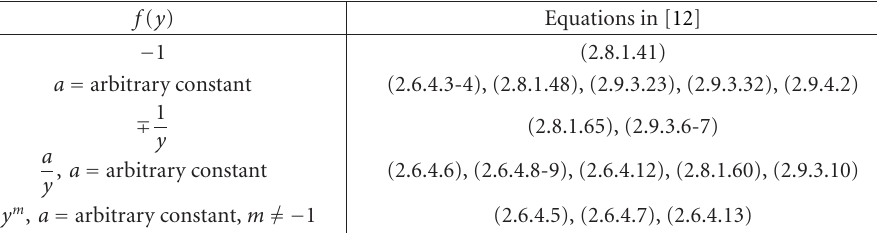
Table 1.1. Cases of the function f (equation